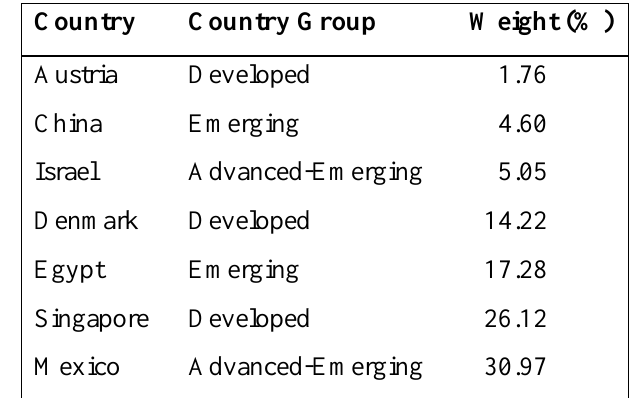
Table 4. Composition of the All-Country Optimal Portfolio of Risky Assets